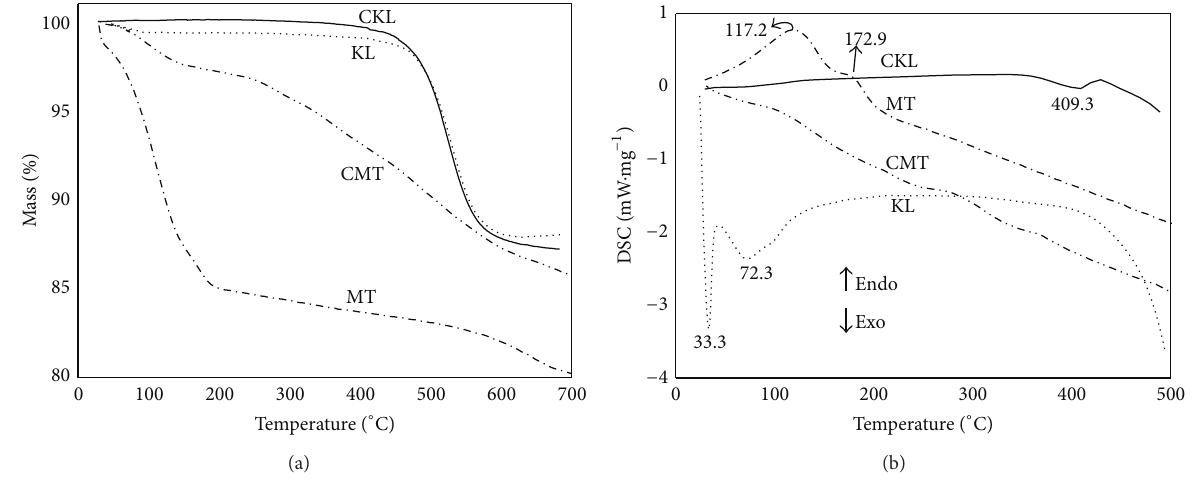
Figure 3: TG (a) and DSC (b) curves of MT, CMT, KL, and CKL.